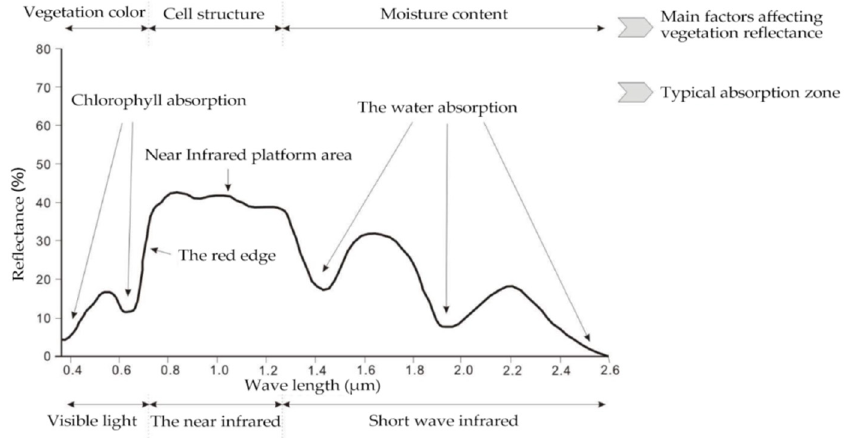
Figure 3. Schematic diagram of plant spectral curve